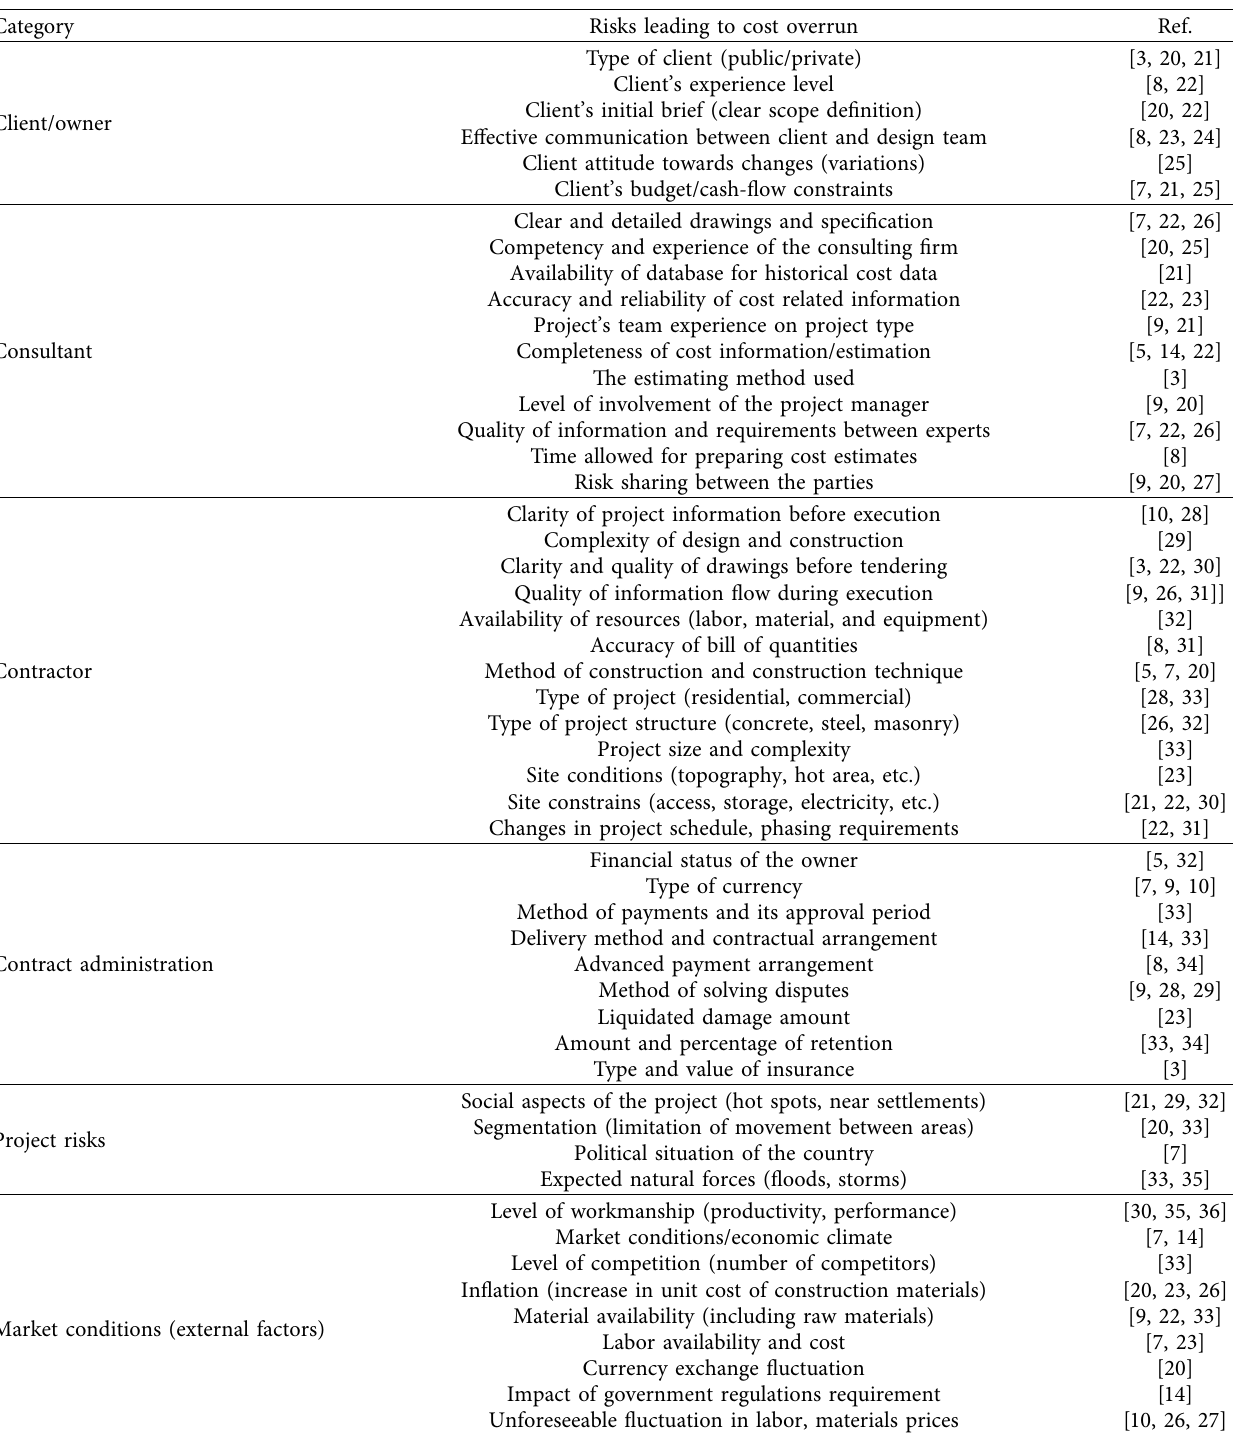
Table 1: Risk factors leading to cost